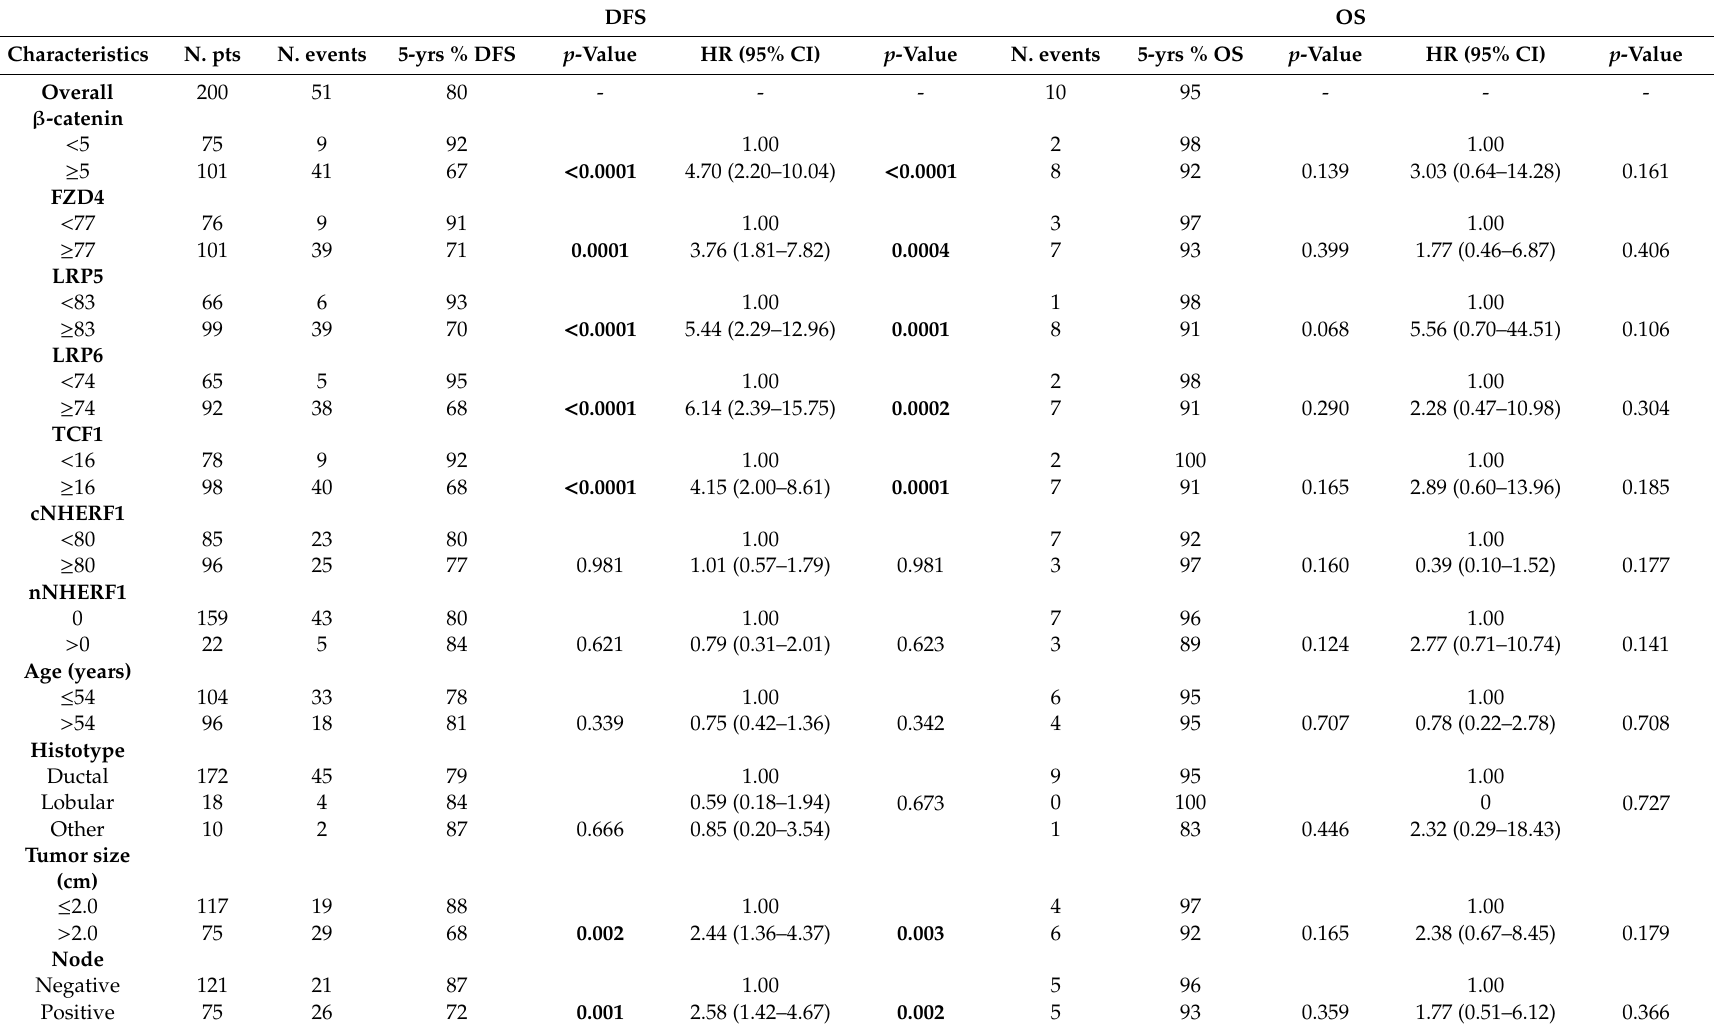
Table 3. Univariate analysis of DFS (disease-free survival) and OS (overall